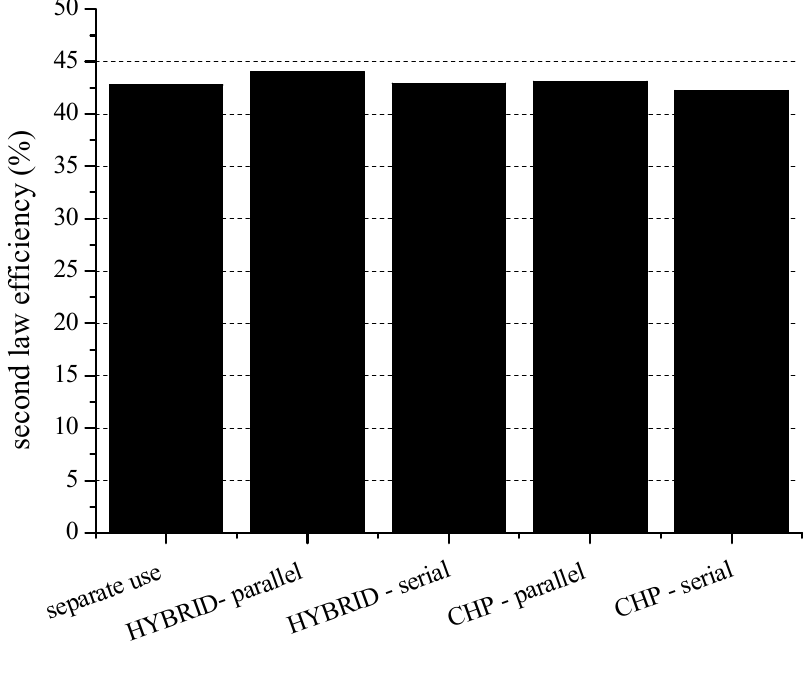
Figure 9. Second law efficiency for the investigated power plant concepts considering geothermal mass flow rate of 65 kg/s and geothermal water temperature of 160